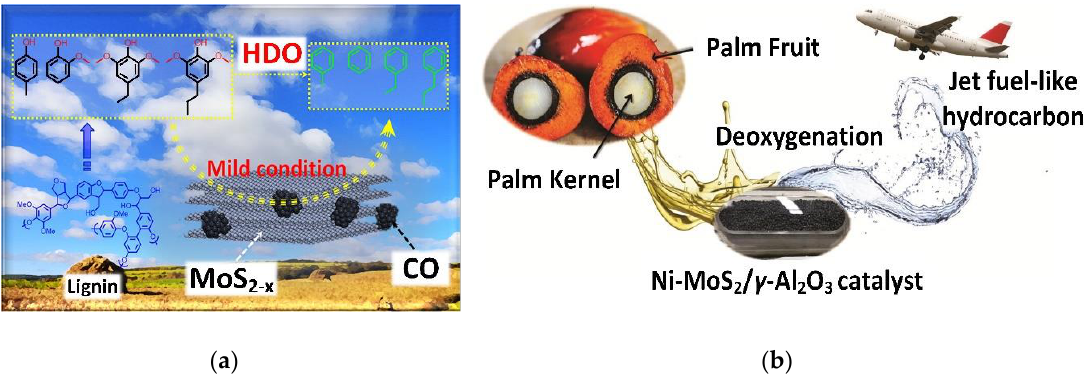
Figure 9. ( a ) Hydrodeoxygenation (HDO) of lignin-derived phenols into arenes using Co-MoS 2 − x (Reproduced with permission from [225]. Copyright 2020 American Chemical Society) and ( b ) deoxygenation of palm kernel oil to jet fuel-like hydrocarbon using catalysts (Reproduced with permission [206]. Copyright 2017 Elsevier B.V.).